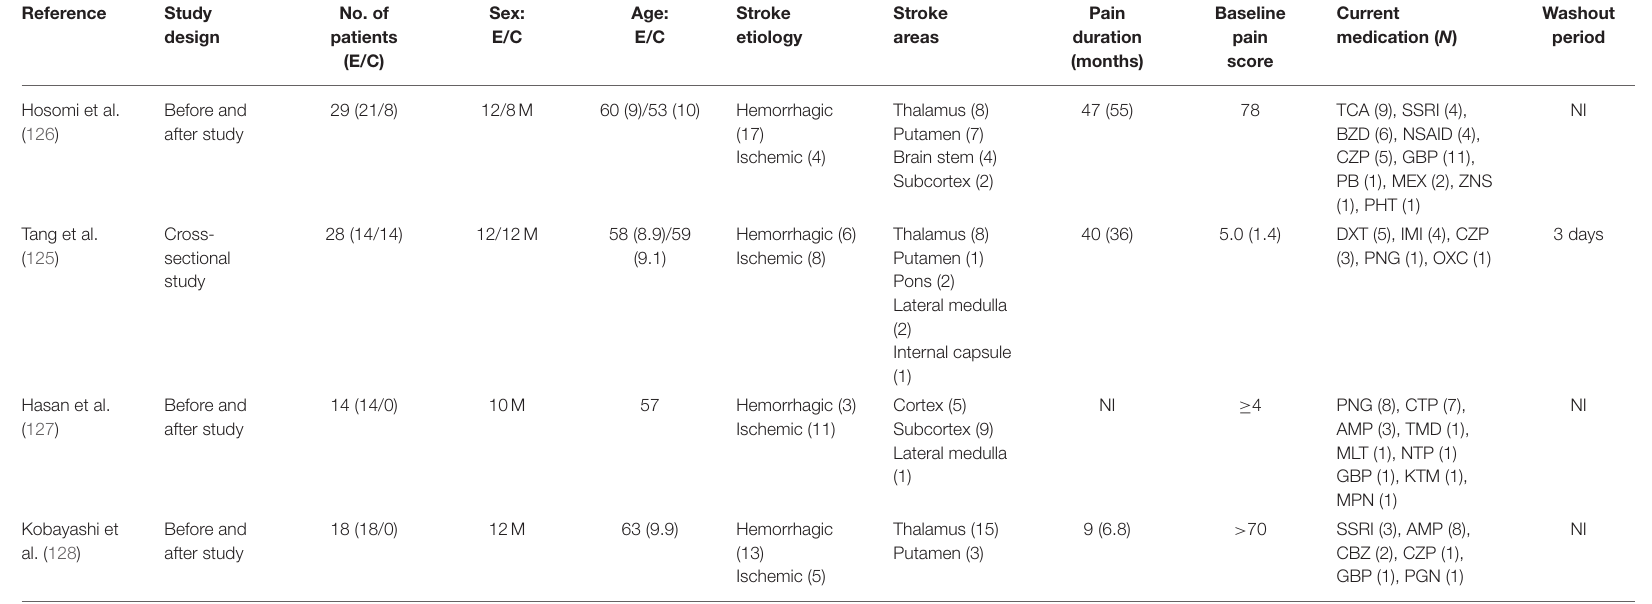
TABLE 2 | Sample characteristics and central nervous system drugs used currently ( n = 67).